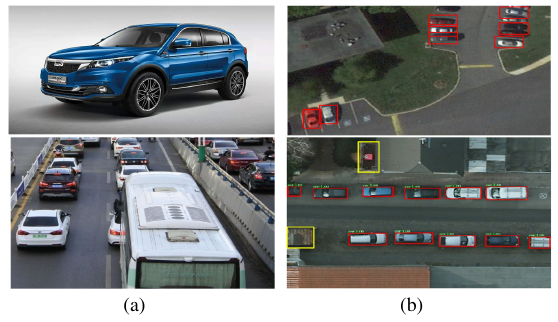
Figure 1. Examples of everyday images of vehicles (a) and remote sensing image of vehicles (b). In remote sensing image, red boxes indicate the correctly detected vehicles and the false alarms are marked with yellow